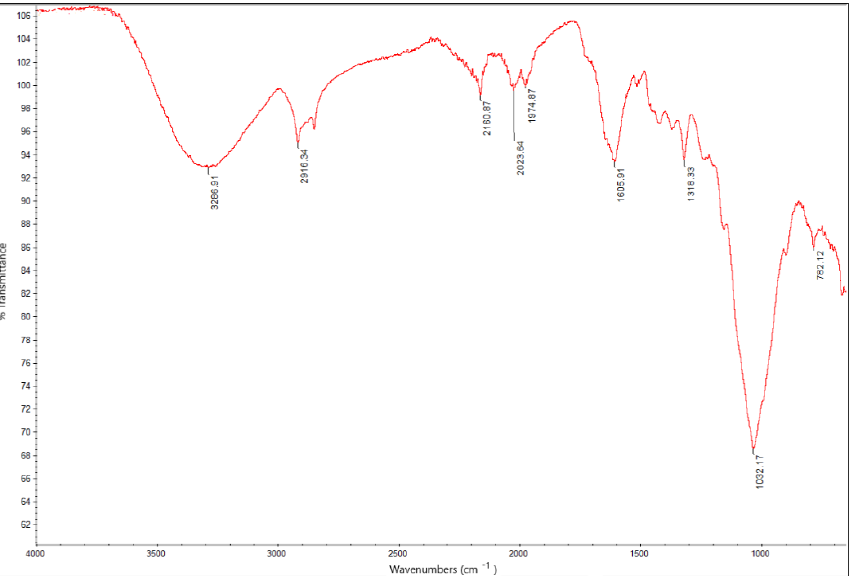
Figure 5. FTIR spectra of rice straw (own source) acquired at room temperature by a Nicolet FTIR iS10 spectrometer (Nicolet, Madison, WI, USA) equipped with Smart iTR with diamond plate on Luna CL rice straw. Just collected straw was washed with distilled water, dried at 45 °C, milled, and sieved with a 1000 μ m mesh sieve before analysis. Thirty-two scans in the 4000–600 cm − 1 range at 4 cm − 1 resolution were coadded. The peaks are indexed by the tool “Find Peaks” in the Omnic Spectra software.